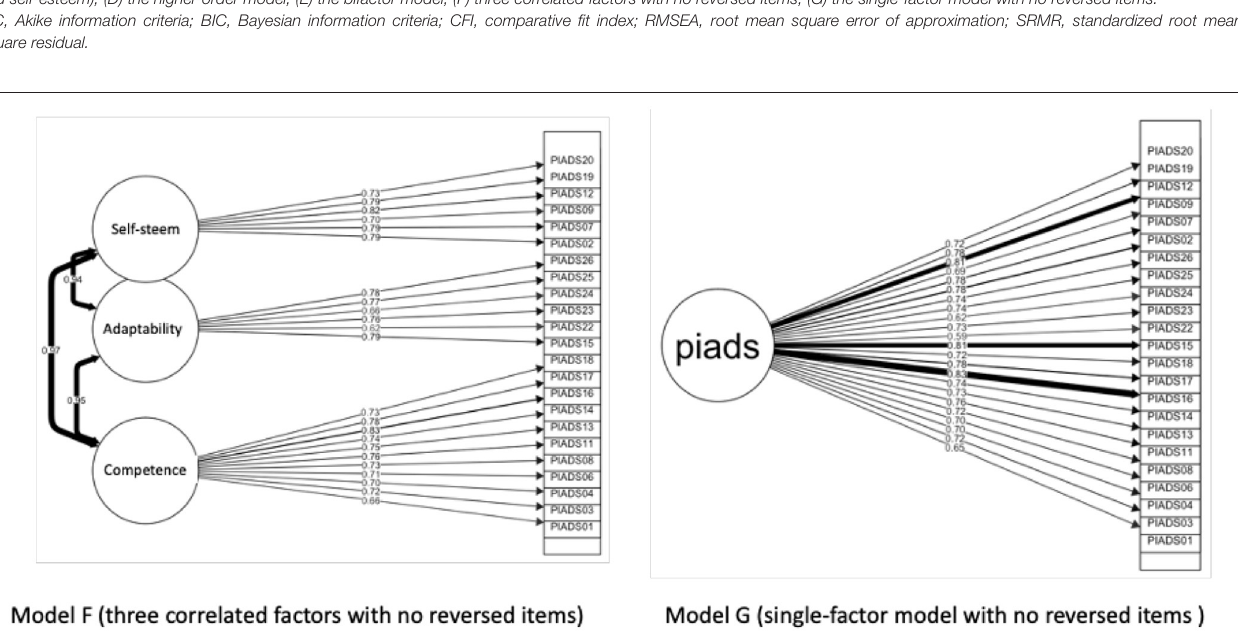
FIGURE 1 | Confirmatory Factor Analysis (CFA) of PIADS Scale with no reversed items. Fit indexes (see Table 3 ) showed the best results for this two models.